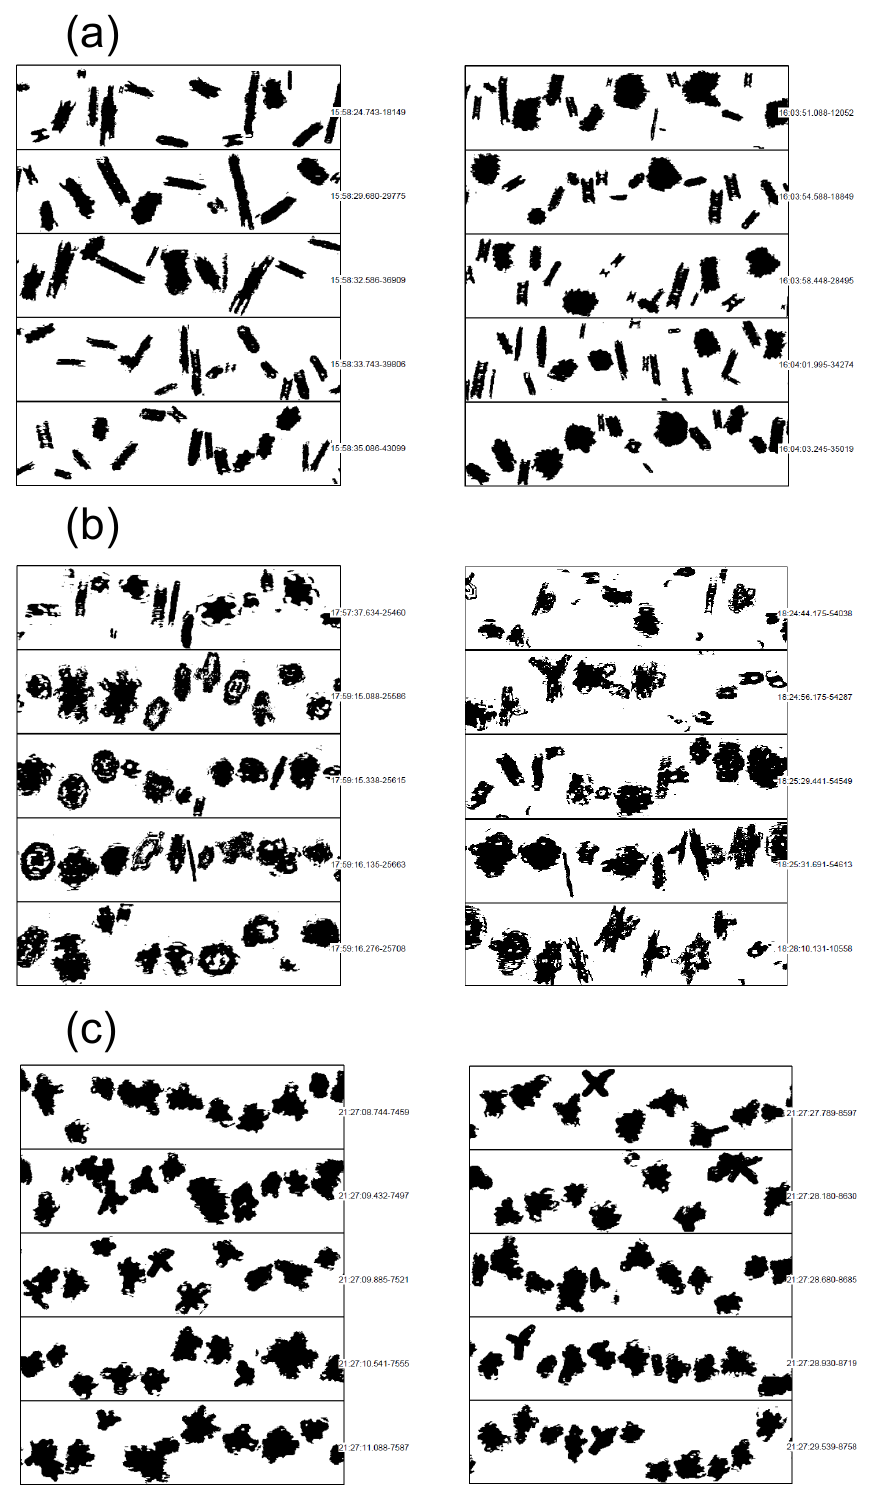
Figure 8. (a) 2DS images of highly irregular particles during a constant altitude run at − 5 ◦ C (400m) during Flight 218. The times given are for the first crystal on each strip. The height of each strip corresponds to the 2DS array width of 1280µm. (b) Similar images for a constant altitude run at − 15 ◦ C during Flight 233 and (c) − 20 ◦ C during Flight